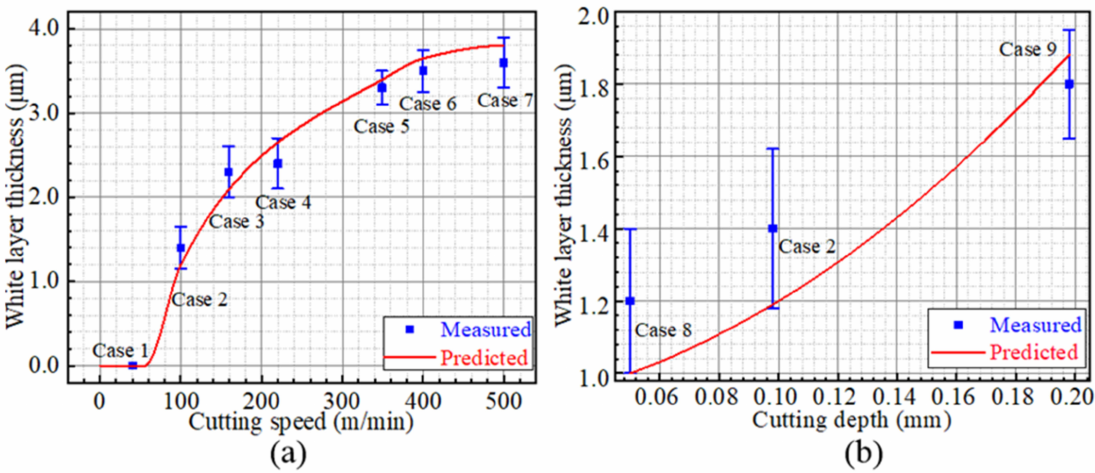
Figure 14. White-layer thickness prediction curves: ( a ) The relationship between white-layer thickness and cutting speed, ( b ) The relationship between white-layer thickness and cutting depth.